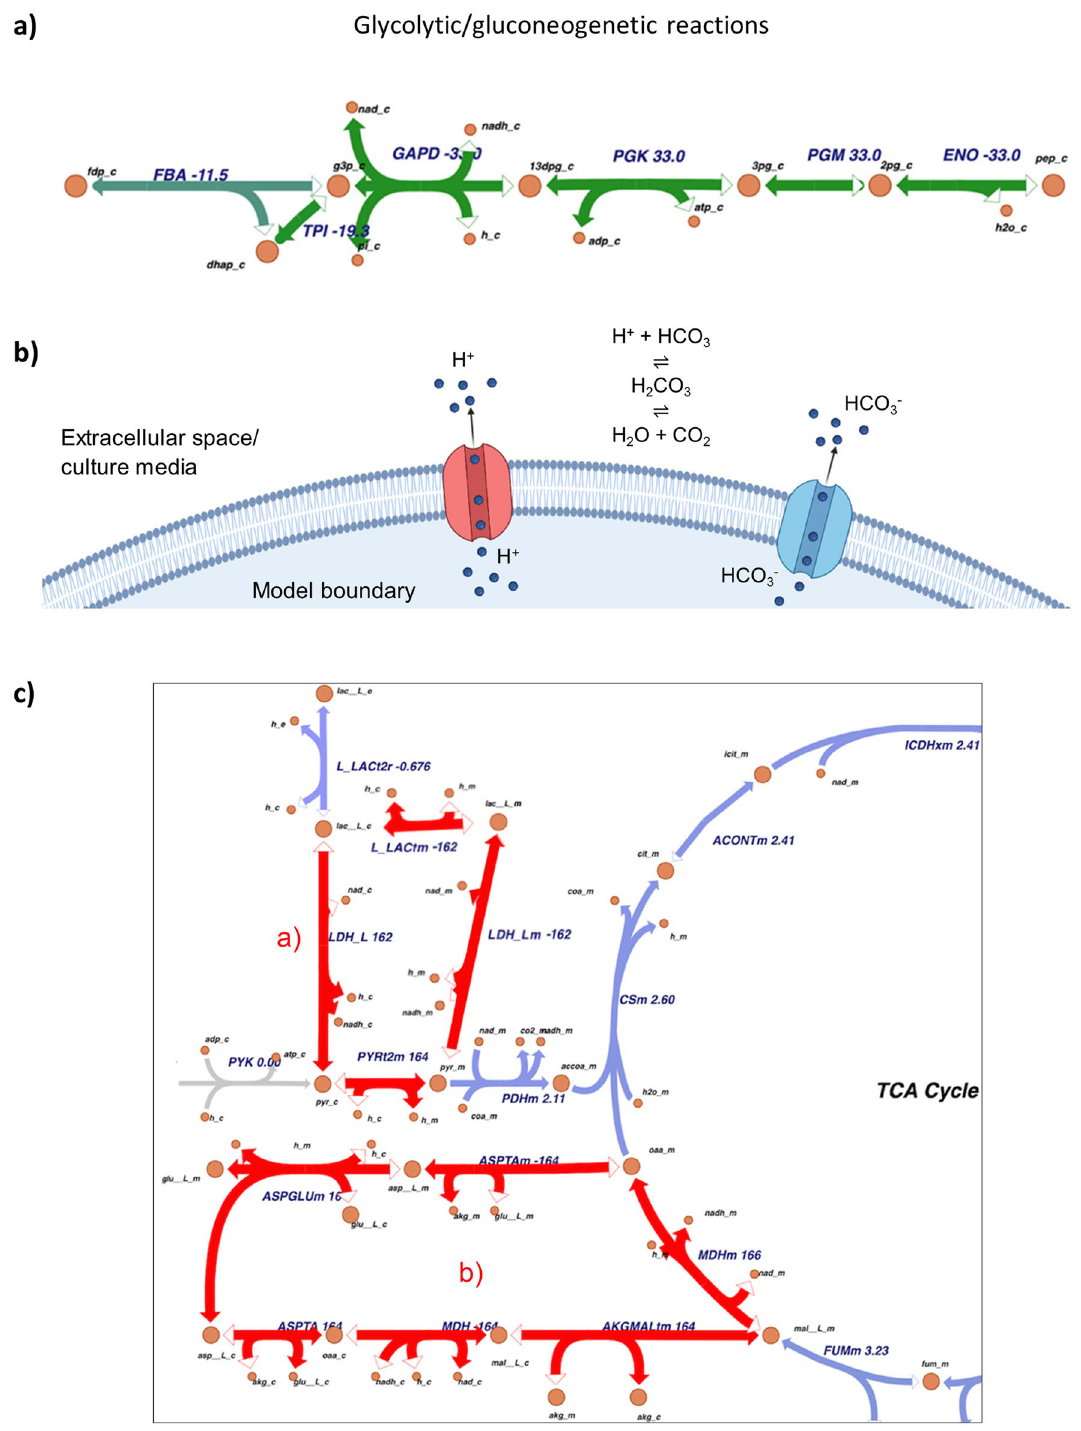
Figure 5. ( a ) Visualisation of six reactions shared by glycolysis and gluconeogenesis. Fluxes were determined by an FBA maximizing biomass production with 1 mmol/(g CDW x h) glucose uptake and all other constraints as default. In this basic state, biomass carbohydrate (synthesized from glucose-6-phosphate) is produced mainly via gluconeogenesis, mostly relying on amino acids supplying the TCA cycle, generating pyruvate, which is then converted into phosphoenolpyruvate. ( b ) Schematic overview of the pH simulation approach. Red: Proton transport channel. Blue: Bicarbonate transport channel. c: Extract of the carbon metabolism of validation run 20, highlighting the two high-flux cycles ( a ) and ( b ). It was modelled using the model without sodium and potassium exchange, simulating